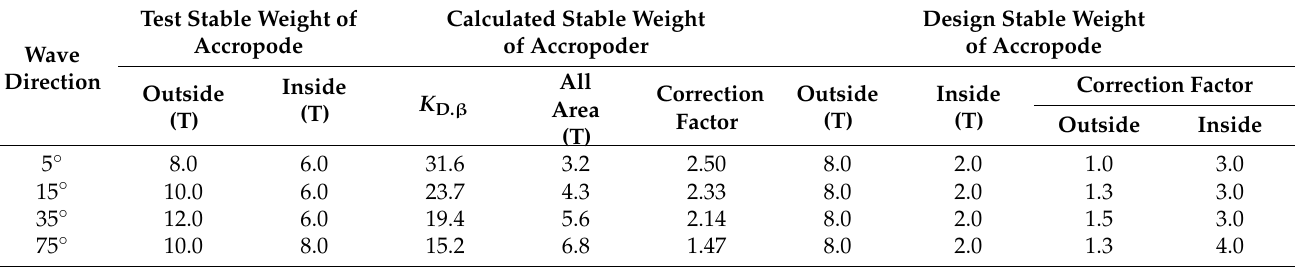
cropode designed at the sea side is unstable and optimized to 12T stability.